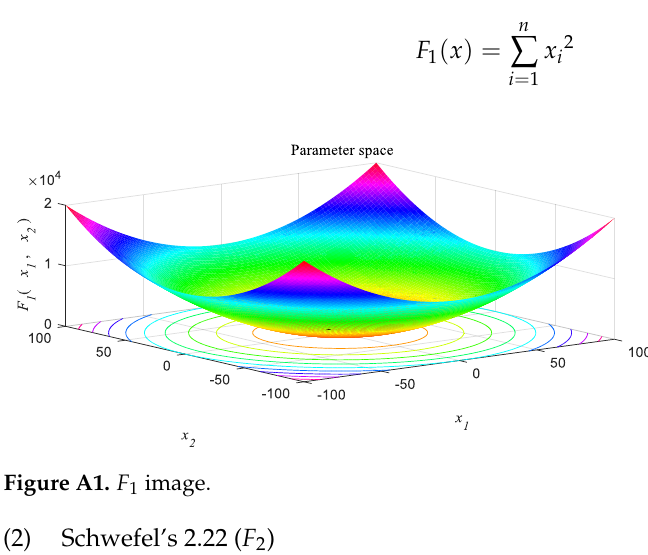
Figure A1. F 1 image.